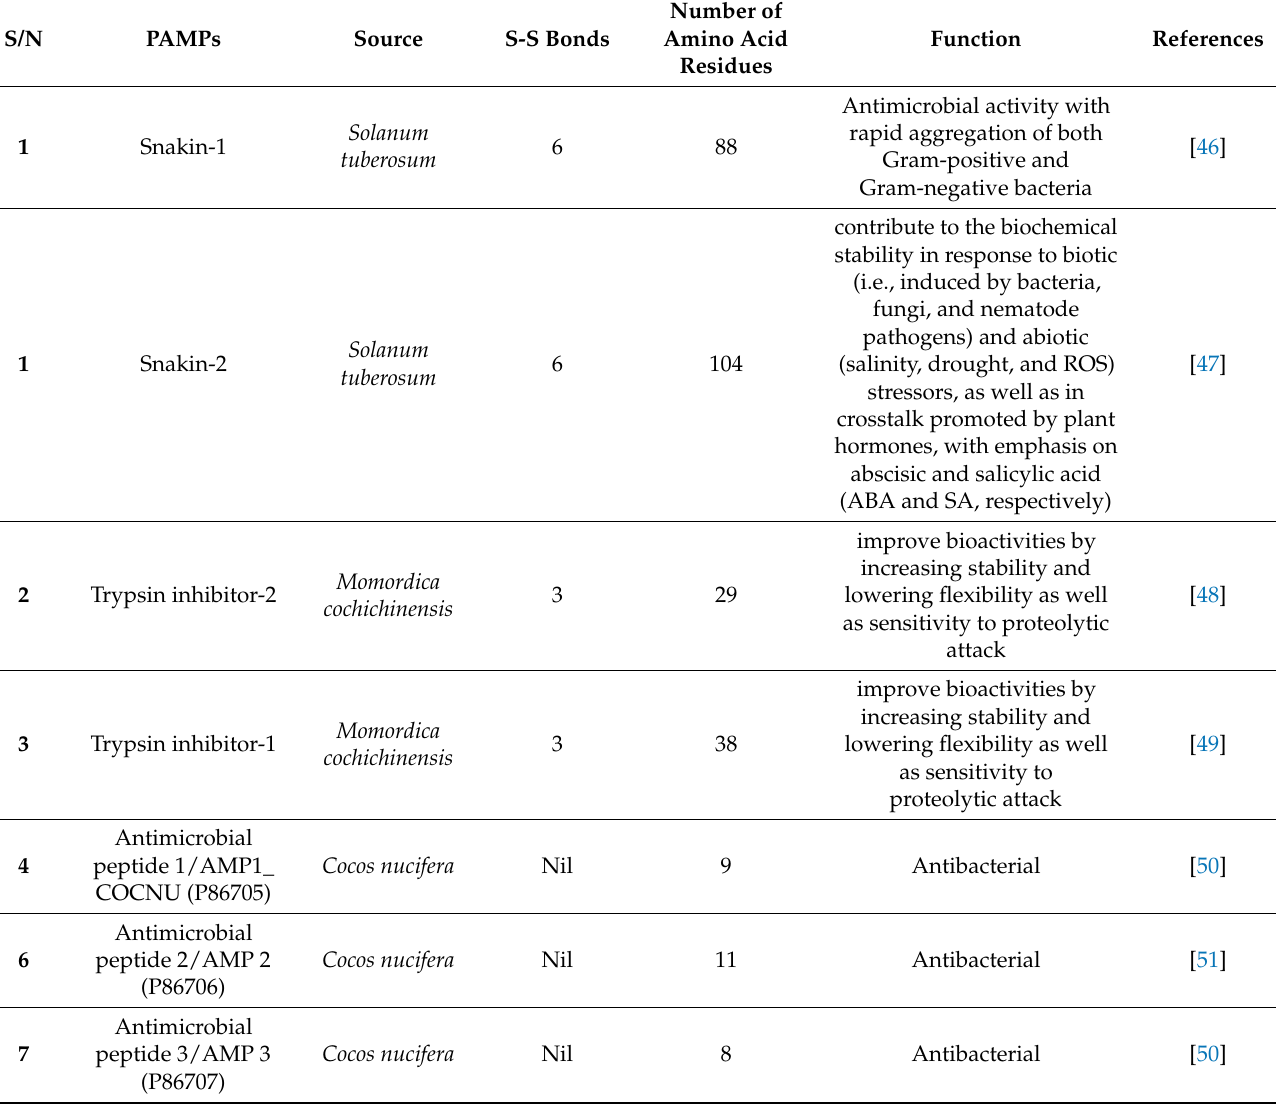
Description of novel plant antimicrobial peptides (PAMPs), their sources, and respective